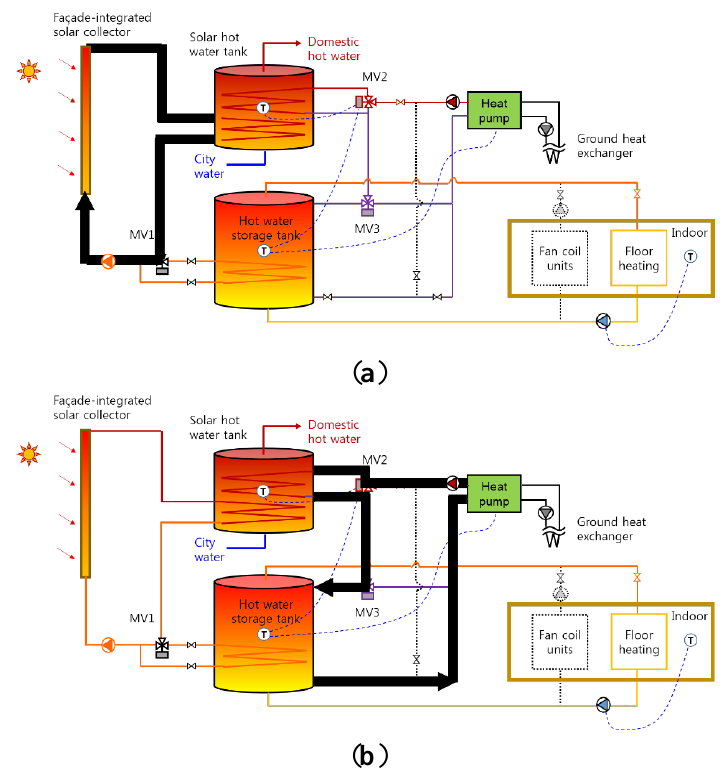
Figure 4. Flow diagram of solar storage control for ( a ) solar heat storage in solar storage tank with MV1 prior to on-peak period and ( b ) discharge from solar storage to buffer storage with MV2 and MV3 during on-peak